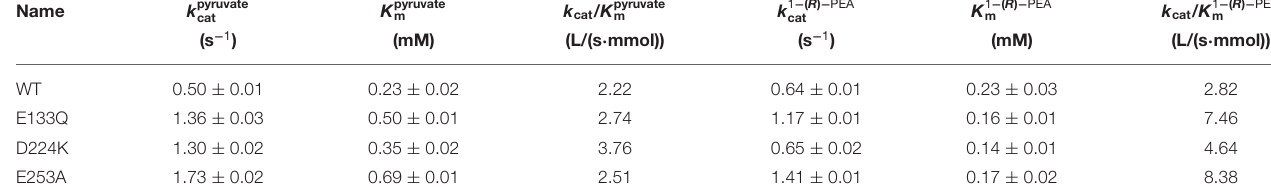
TABLE 2 | Steady-state kinetic constants of wild-type and stabilized mutant At -ATAs.